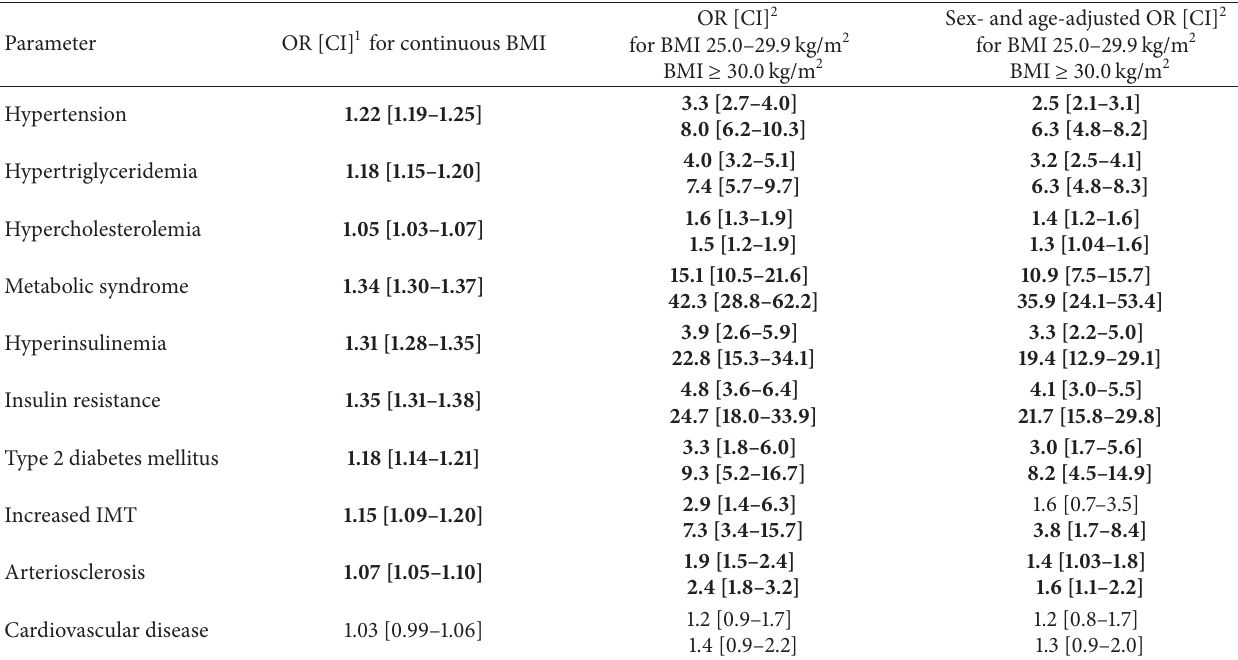
Table 4: BMI-dependent risk determination.